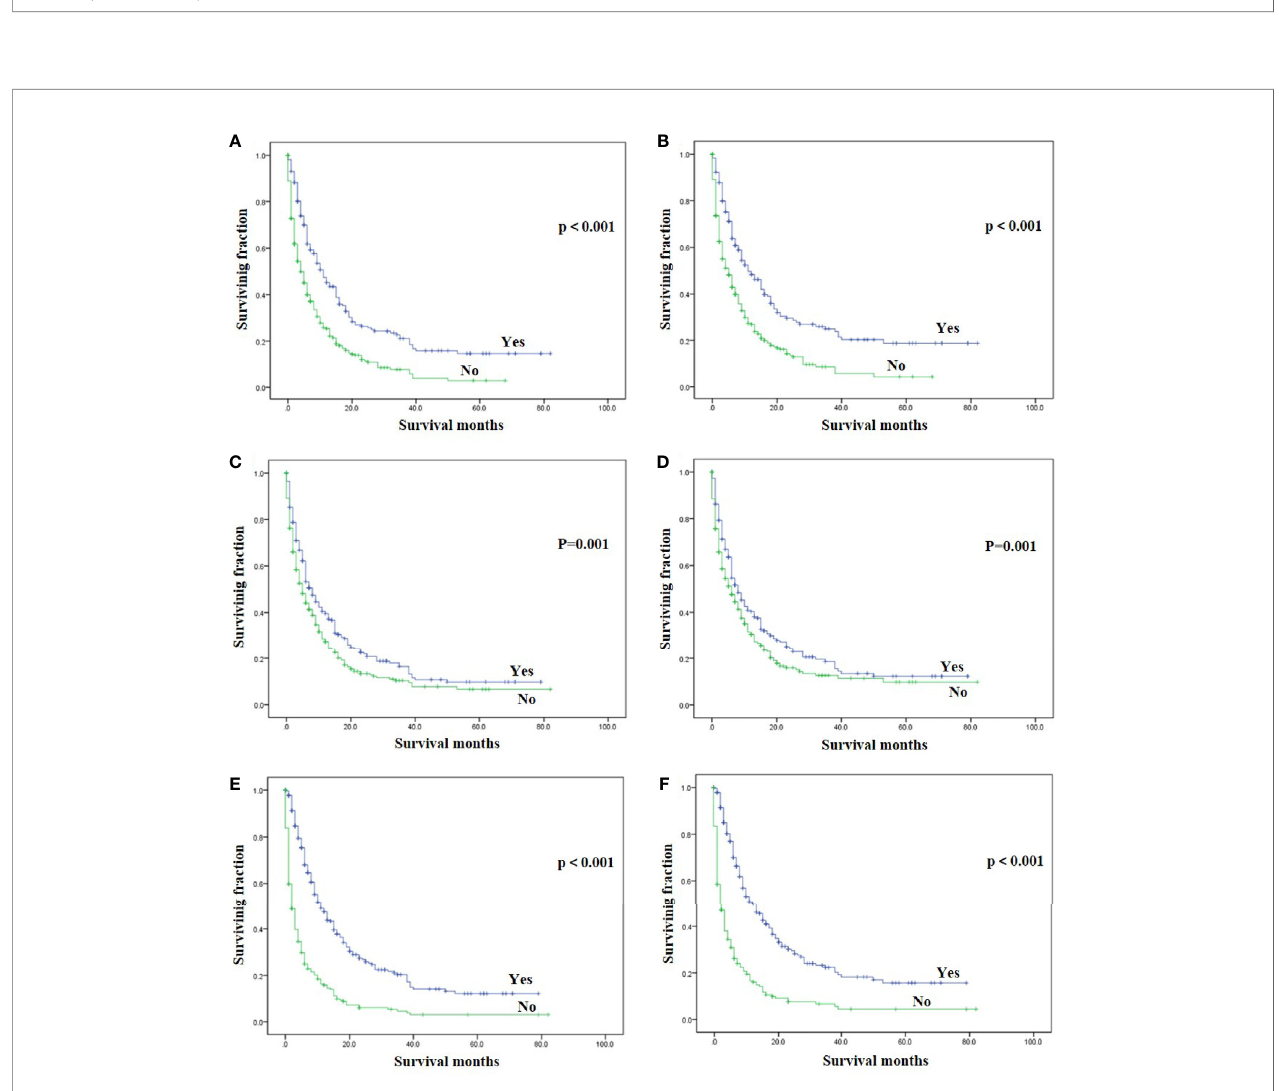
FIGURE 2 | Kaplan-Meier method estimated OS and CSS in endometrial cancer bone metastasis strati fi ed by treatment methods. (A) OS strati fi ed by surgery; (B) CSS strati fi ed by surgery; (C) OS strati fi ed by radiotherapy; (D) CSS strati fi ed by radiotherapy; (E) OS strati fi ed by chemotherapy; (F) CSS strati fi ed by chemotherapy. (OS, overall survival; CSS, cancer-speci fi c